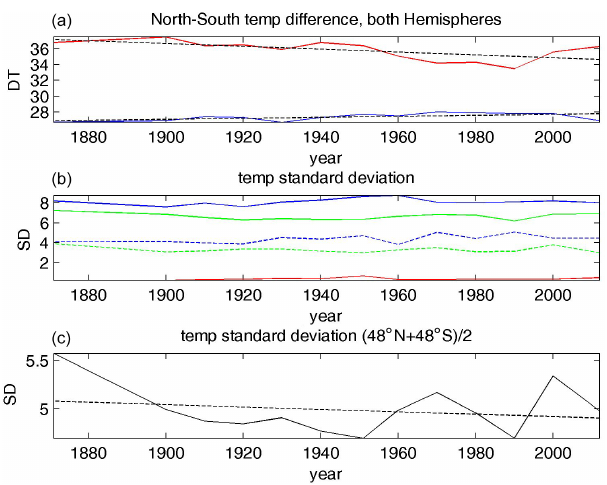
Figure 11. NCEP reanalysis data of 500hPa temperature. (a) (cid:49)T trend from 1871 to 2012, Northern Hemisphere (blue) and South- ern Hemisphere (red). The linear regression (dashed line) shows a trend towards smaller north–south temperature differences in the Southern Hemisphere ( T ( 2012 ) − T ( 1871 ) = − 2 . 51K) but a slightly larger difference for the Northern Hemisphere ( T ( 2012 ) − T ( 1871 ) = 0 . 88K). (b) Zonal mean temperature standard devia- tions for 88 ◦ N, 88 ◦ S (solid blue, dashed blue), 48 ◦ N, 48 ◦ S (solid green, dashed green), and equatorial (red). (c) Mid-latitude zonal mean temperature standard deviation of ( (T ( 48 ◦ N ) + T ( 48 ◦ S ))/ 2) (solid line) and linear regression (dashed line). There is a weak trend towards decreasing standard deviation ( σ T ( 2012 ) − σ T ( 1871 ) = − 0 .